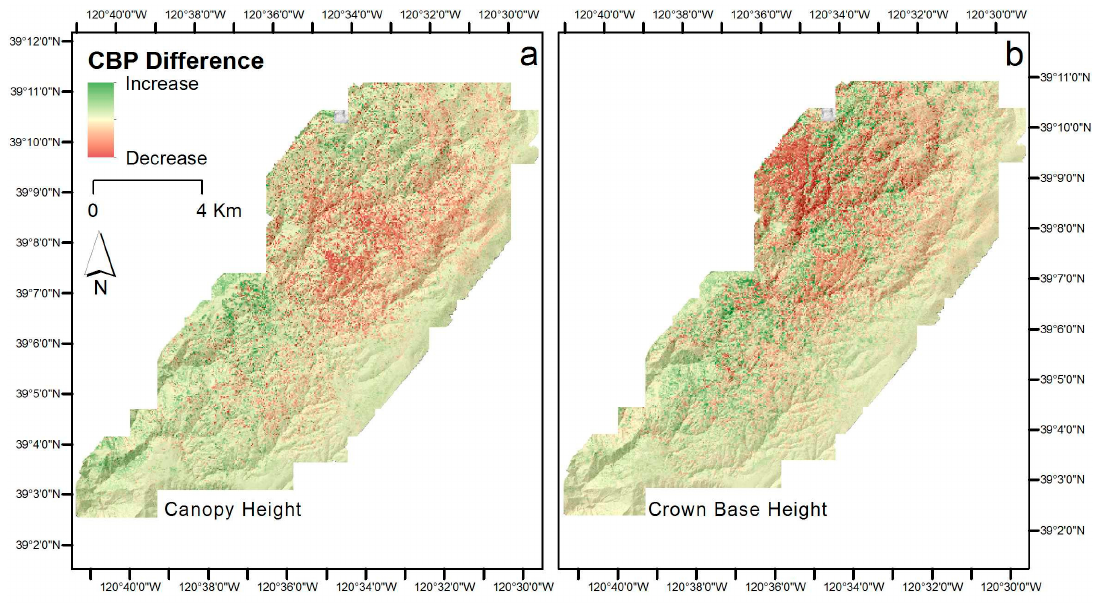
Figure 4. Difference in modeled conditional burn probability for ( a ) Model 2 (Canopy Height + Error) minus Model 1 (original data), and ( b ) Model 3 (Canopy Base Height + Error) minus Model 1 (original data).